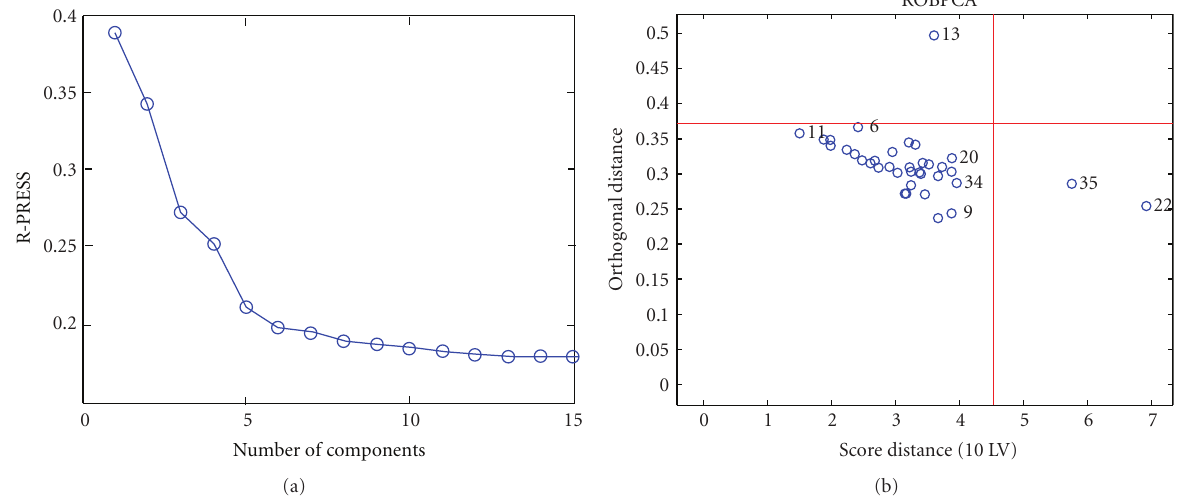
Figure 4: Robust PCA outlier diagnosis of the transgenic cotton leaves based on raw